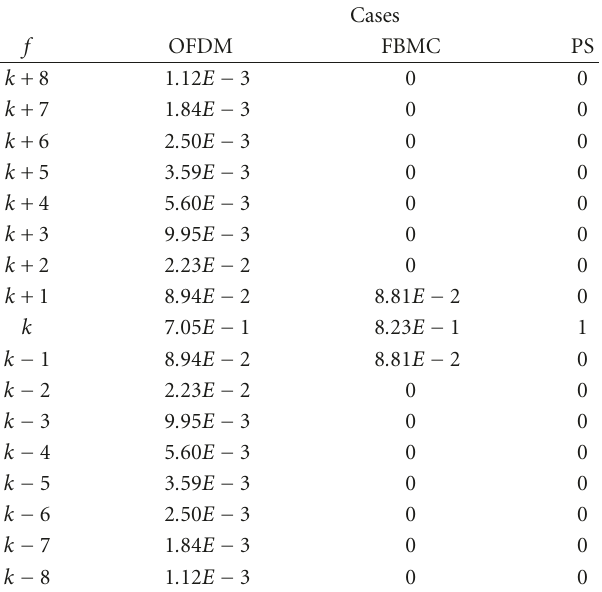
Table 3: Intercell interference power tables for three di ff erent